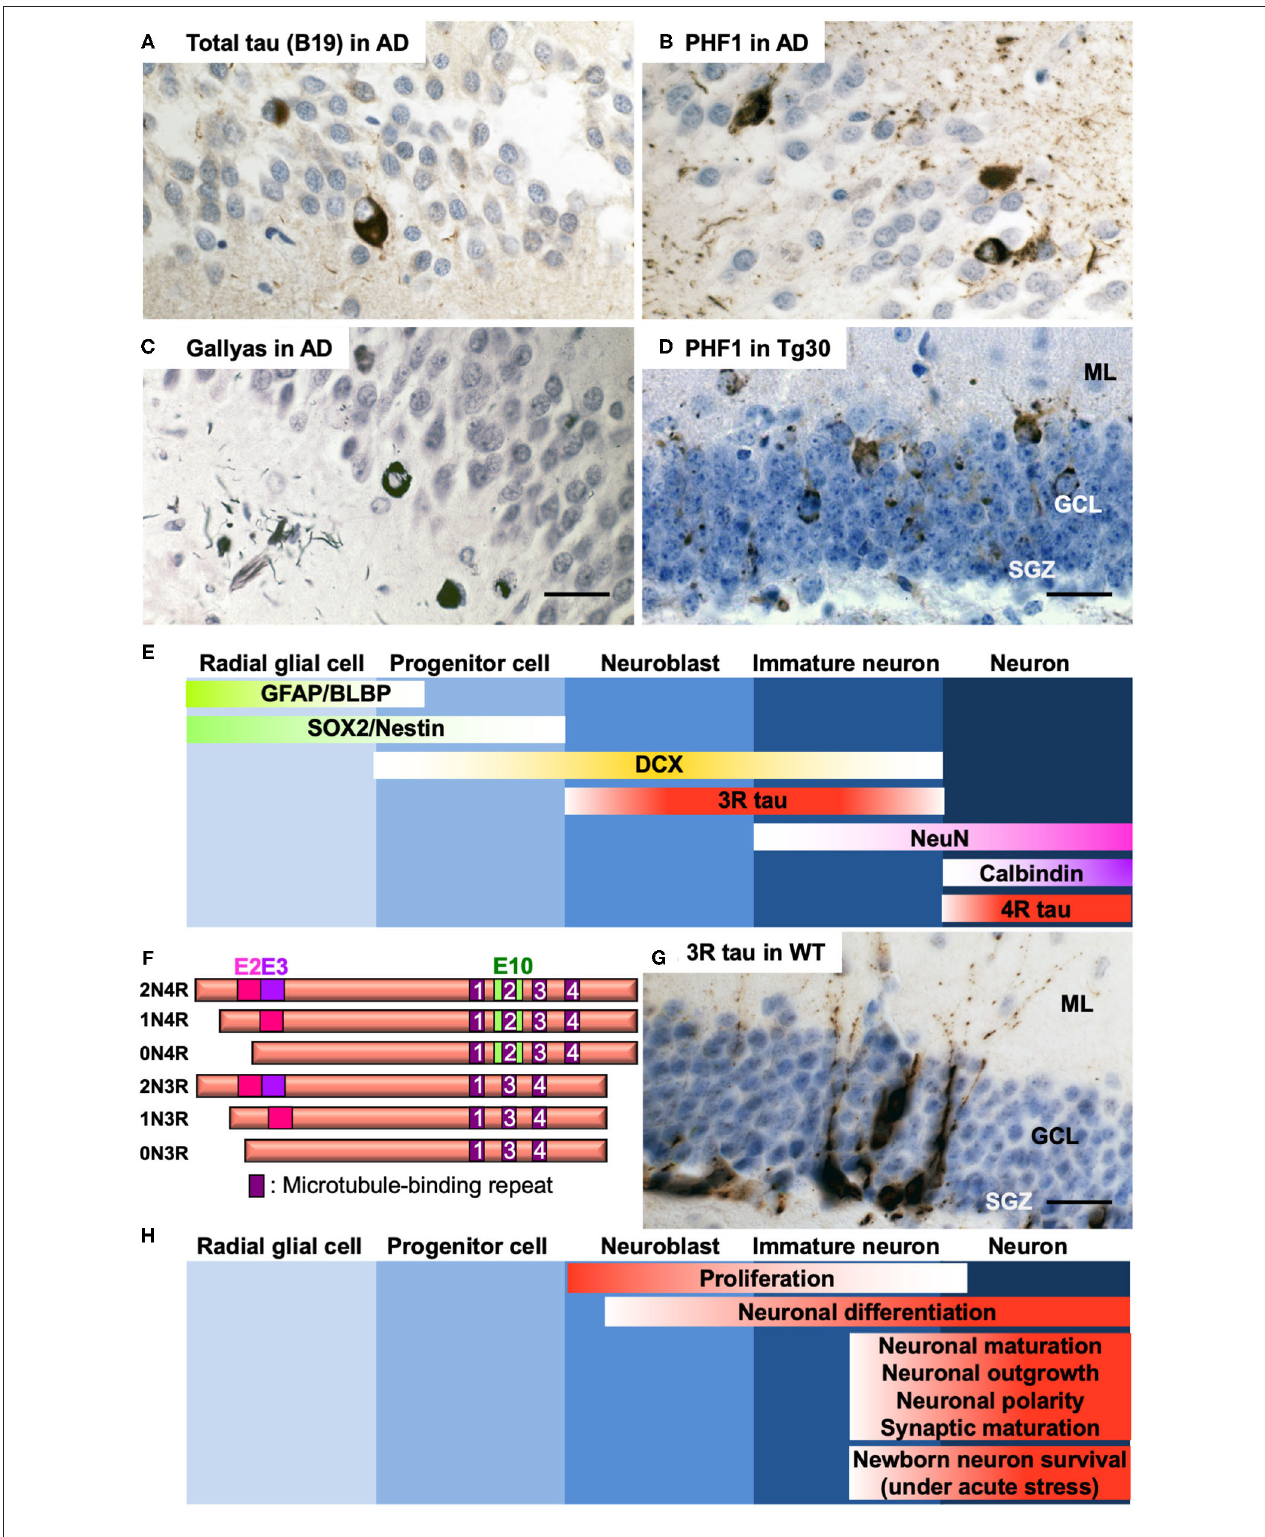
FIGURE 1 | (A–C) Representative photos of tau pathology detected in the DG of post-mortem brain section of a 65-year-old male AD patient (Braak VI). Tau pathology was detected by anti-total tau B19 antibody (9) (A) , anti-phospho Ser396/404 tau PHF1 antibody (10) (B) , or by Gallyas silver staining (11) (C)